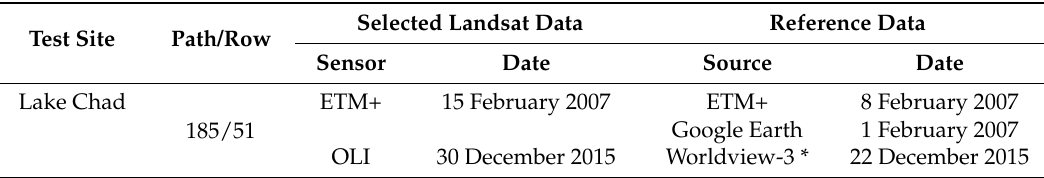
Table 2. Description of Landsat 7/OLI scenes and corresponding reference